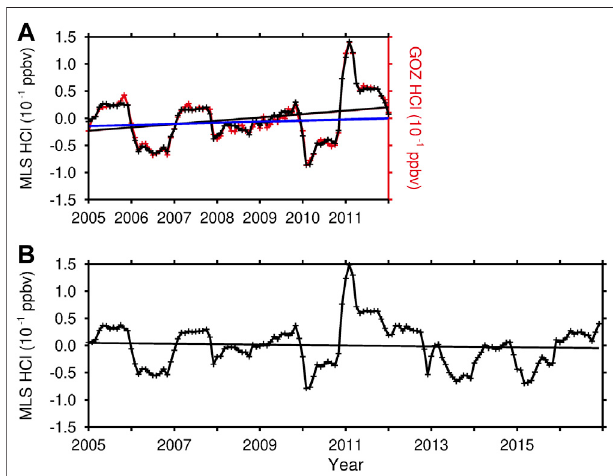
FIGURE1| Time series ofHClanomaly(units:10 − 1 ppbv) from (A) 2005 to2011basedonMLSdata(black)andGOZCARDSdata(red),and (B) based on MLS data, but from 2005 to 2016. The straight black lines in (A,B) are the lineartrendsofHClvariations.Thebluelinein (A) isalsoalineartrendbut withtheHClvariationsfromDecember2010toMarch2011removed.TheHCl anomalies are averaged in the region 30 – 58 ° N and 10 – 68 hPa and the seasonal cycle has been removed.